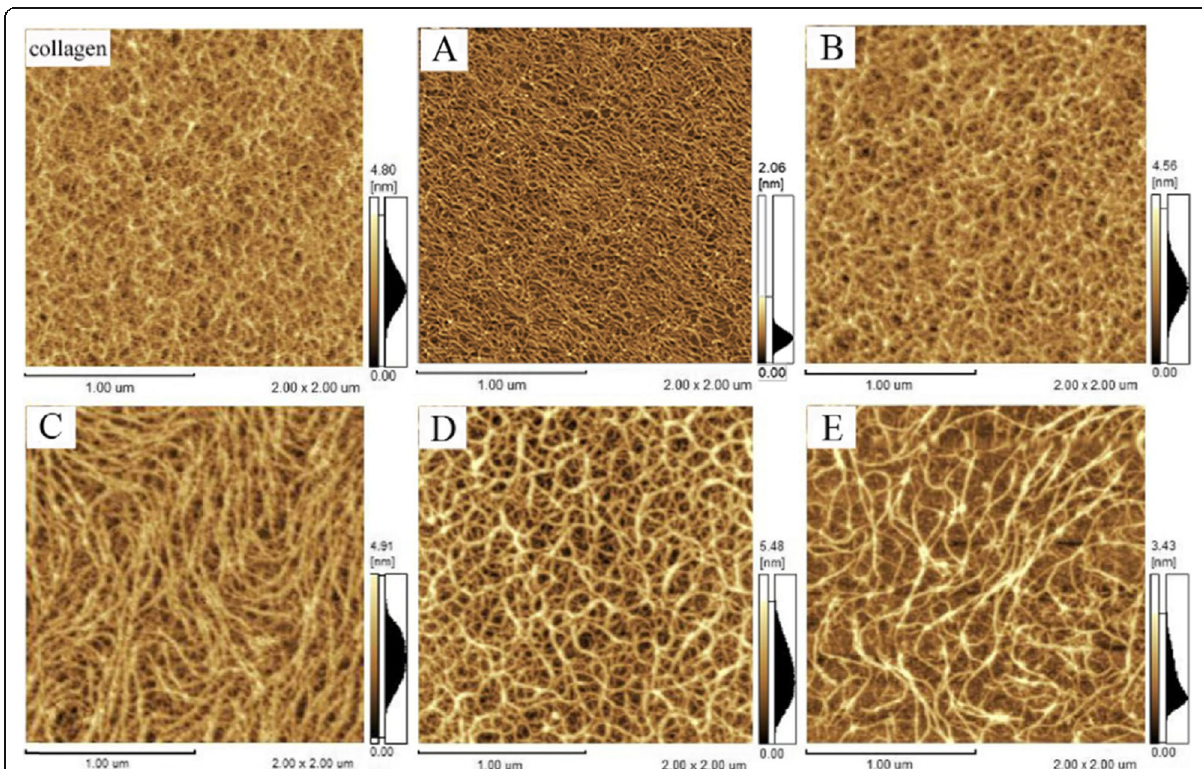
Fig. 3 AFM images of the native collagen and the insoluble collagen fibers derived from different ILs: a Col/ILs-fibrils70%B. b Col/ILs-fibrils10%. c Col/ILs-fibrils30%. d Col/ILs-fibrils50%. e Col/ILs-fibrils70%